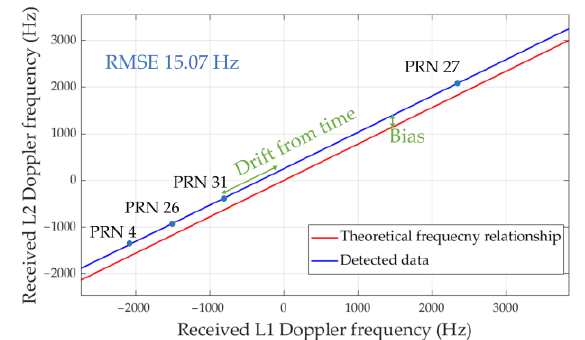
Figure 3. Received Doppler frequencies at two GPS bands from the experiments.